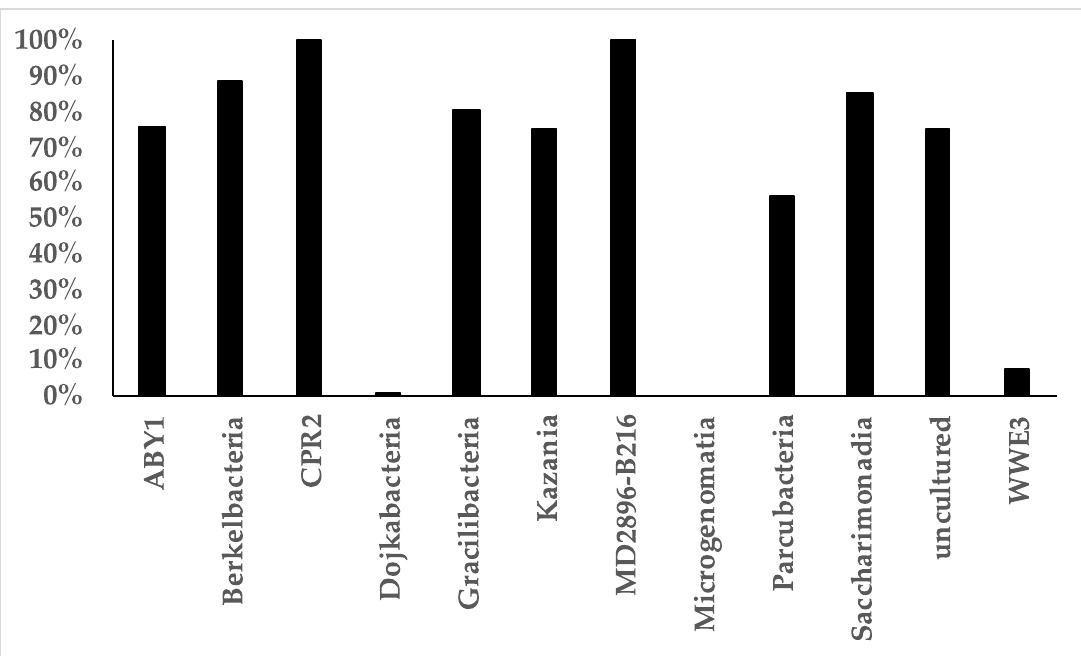
Figure A1. Coverage of primer set Bakt_341F/805R of various Cand. Patescibacteria clades and orders.